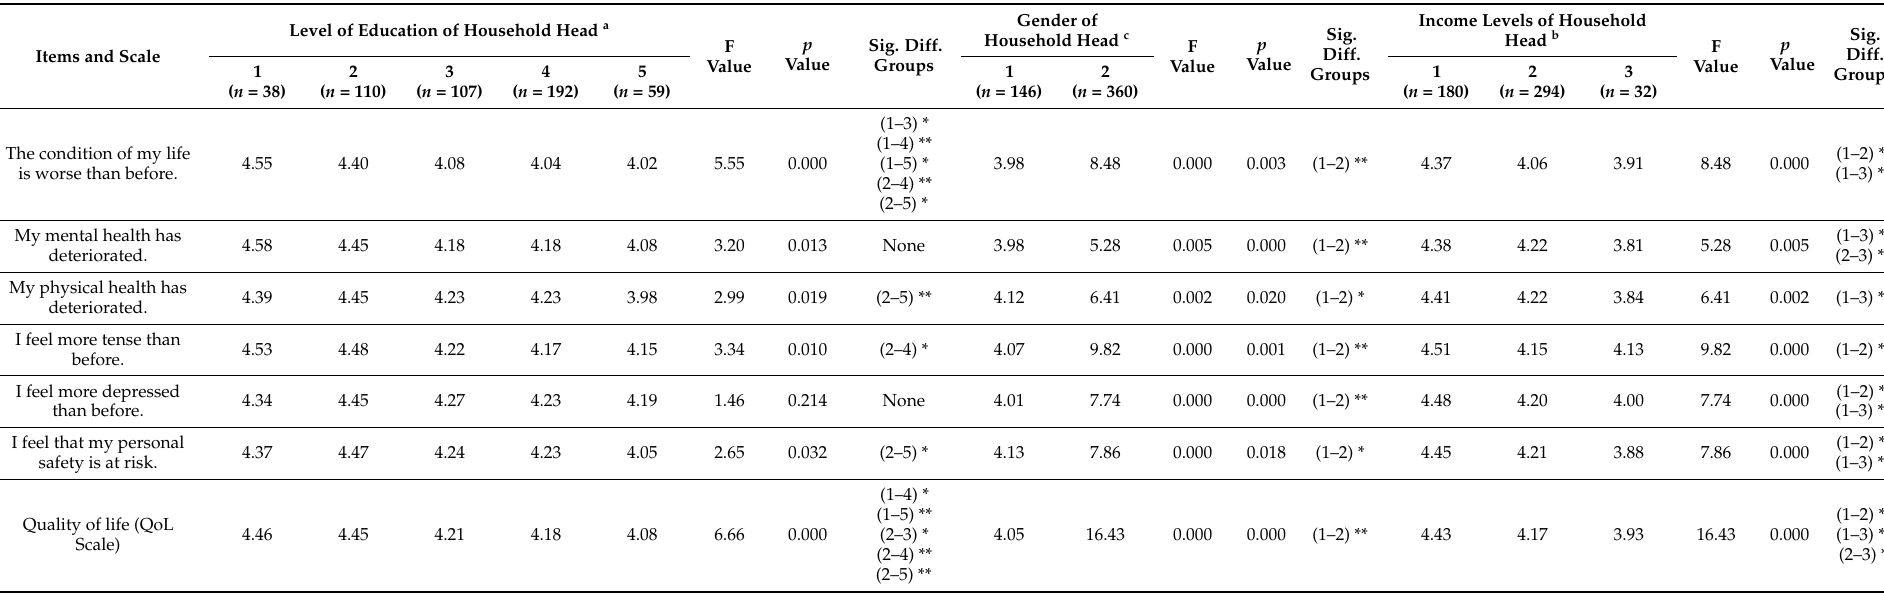
Table 3. ANOVA for mean scores of respondents on QoL items and QoL scale classified by education levels, home ownership, and gender. Level of Education of Household Head a Items and Scale